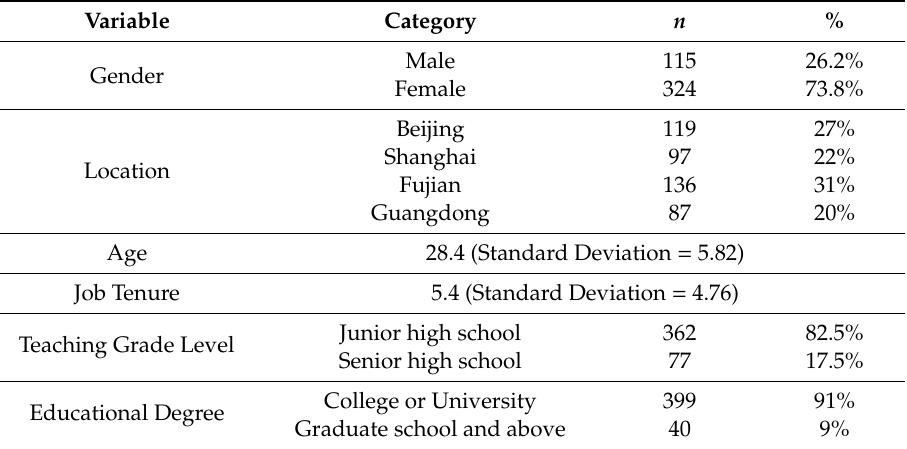
Table 1. The characteristics of the